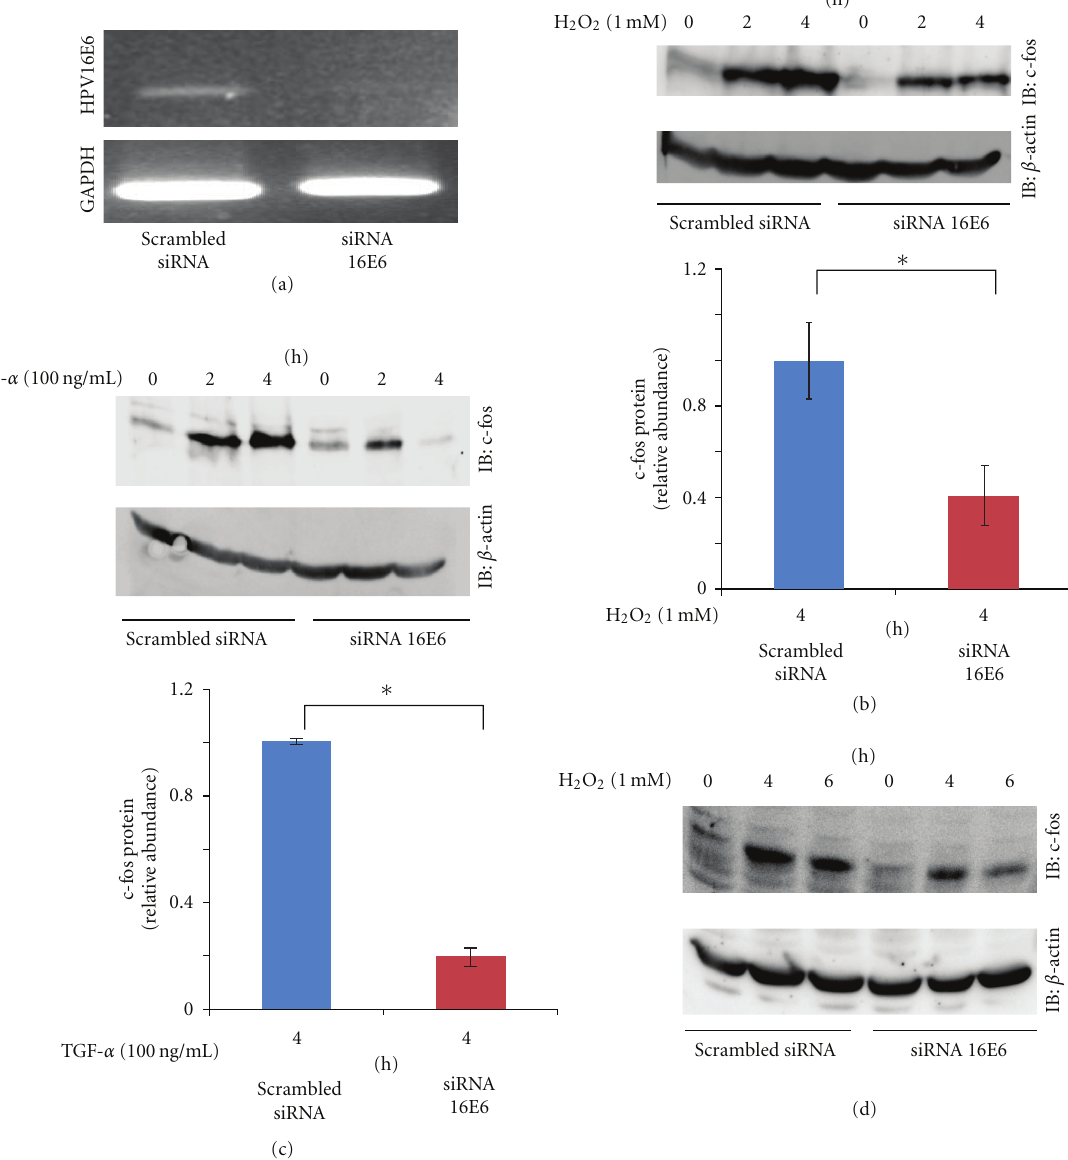
Figure 3: HPV16E6-mediated upregulation of c-fos in SiHa cells. (a) The mRNA levels of HPV16E6 were detected by RT-PCR after HPV16E6 siRNA transfection into SiHa cells. Cells were transfected with scrambled siRNA or HPV16E6 siRNA for 24 hours. (b) HPV16E6- mediated upregulation of c-fos expression in SiHa cells after H 2 O 2 exposure. The transfected cells were exposed to H 2 O 2 (1mM) and harvested at the indicated time points, before being subjected to Western blotting analysis. Representative blots are shown and include β -actin as a loading control, along with the results of densitometric analysis (4h; normalized to β -actin). ∗ P < 0 . 05, n = 4. (c) HPV16E6-mediated upregulation of c-fos expression in SiHa cells after TGF- α exposure. Transfected cells were exposed to TGF- α (100ng/mL) and harvested at the indicated time points, before being subjected to Western blotting analysis. Representative blots are shown and include β -actin as a loading control, along with the results of densitometric analysis (4h; normalized to β -actin). ∗ P < 0 . 05, n = 4. (d) HPV16E6-mediated upregulation of c-fos expression in Caski cells after H 2 O 2 exposure. The transfected cells were exposed to H 2 O 2 (1mM) and harvested at the indicated time points, before being subjected to Western blotting